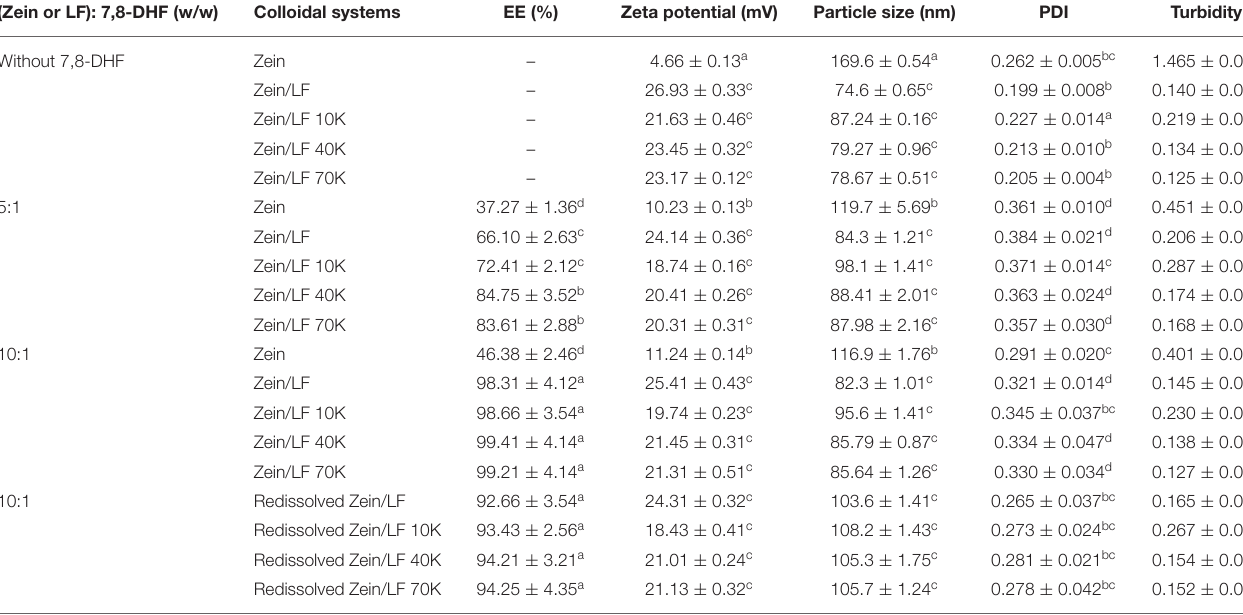
TABLE 1 | Entrapment efficiency (EE), zeta potential, particle size, polydispersity index (PDI), and turbidity of 7,8-dihydroxyflavone (7,8-DHF) in different colloidal systems. (Zein or LF): 7,8-DHF (w/w) Without